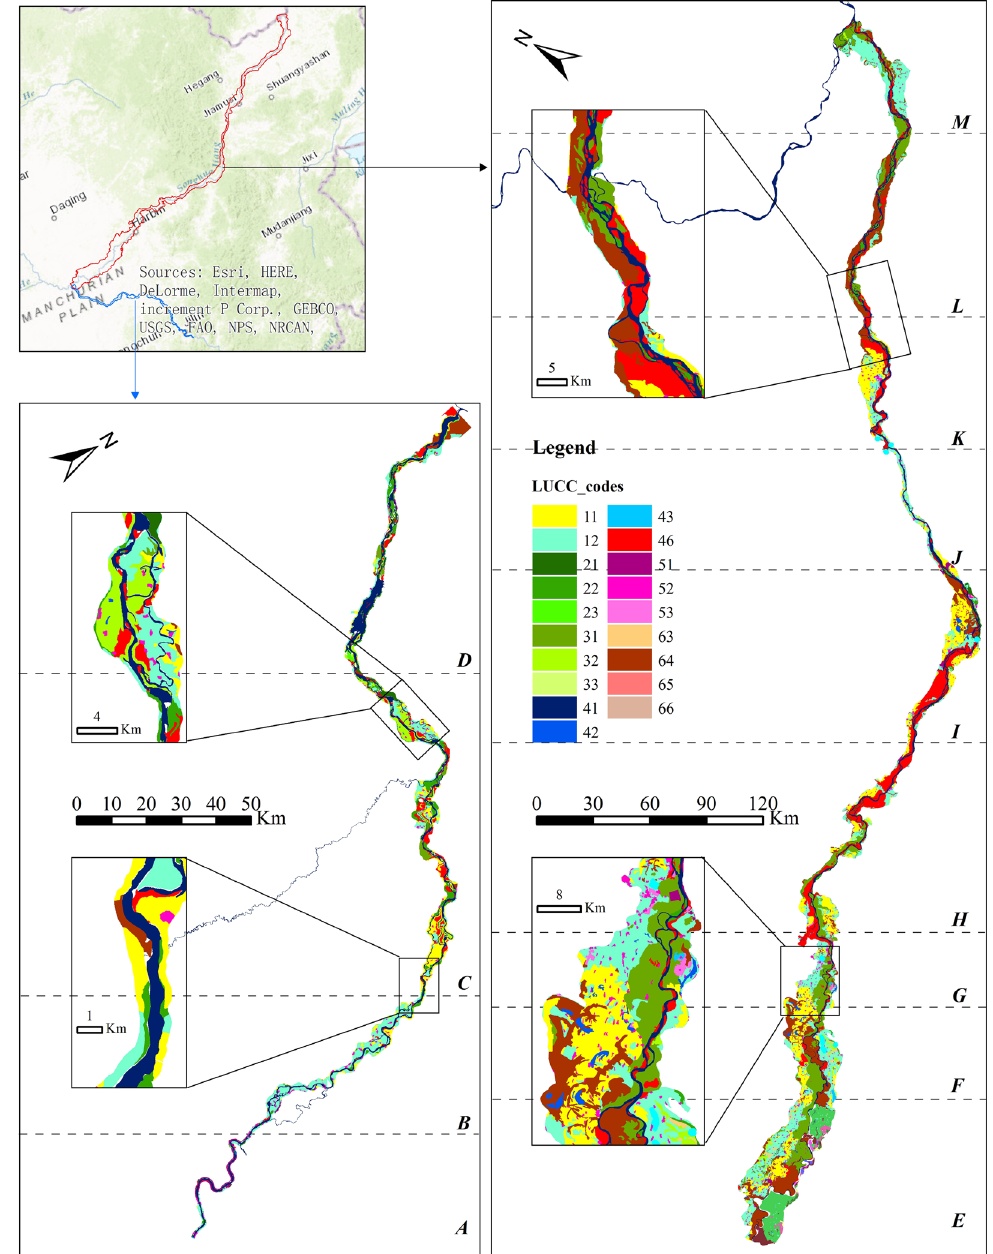
Figure 2. This figure illustrates the land-use data at 1:100,000 scale for riparian zone in 2012. The LUCC_codes represent different land-use types, i.e., 11–12: paddy field, glebe field; 21–23: arboreal forest, sparse woodland and shrub woodland; 31–33: high-, mid- and low-cover grassland; 41–43: rivers, lakes and reservoirs; 46: beach; 51–53: residential, rural and transportation; 63: saline-alkali soil land; 64: wetland; 65–66: Barren land.